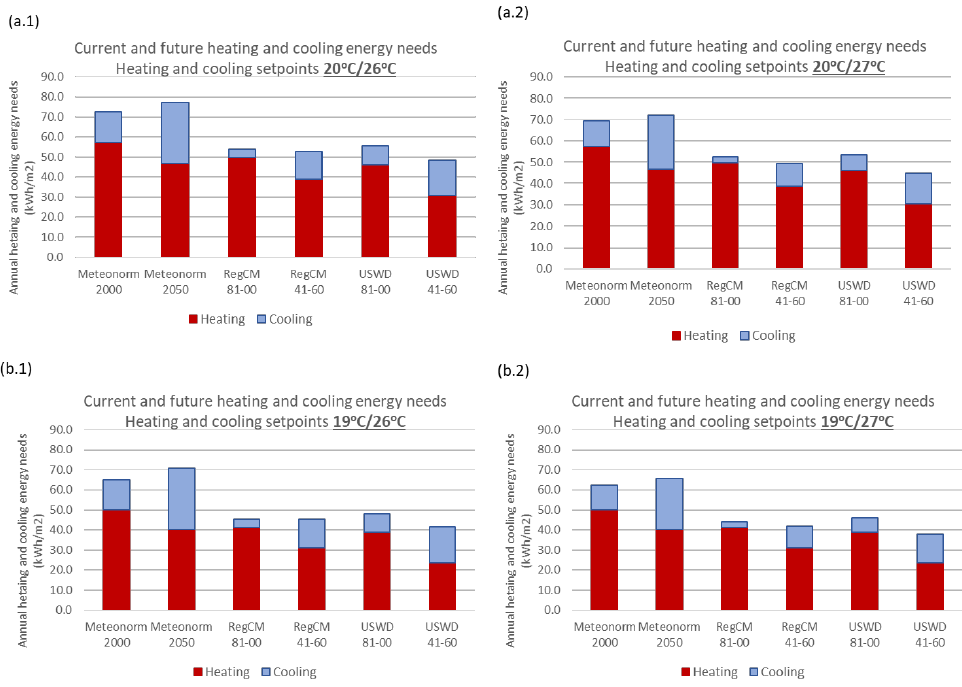
Figure 12. Current and future heating and cooling loads of the examined building unit for all the generated weather datasets and for the examined heating/cooling setpoints of ( a.1 ) 20 °C/26 °C, ( a.2 ) 20 °C /27 °C, ( b.1 ) 19 °C /26 °C and ( b.2 ) 19 °C /27 °C.